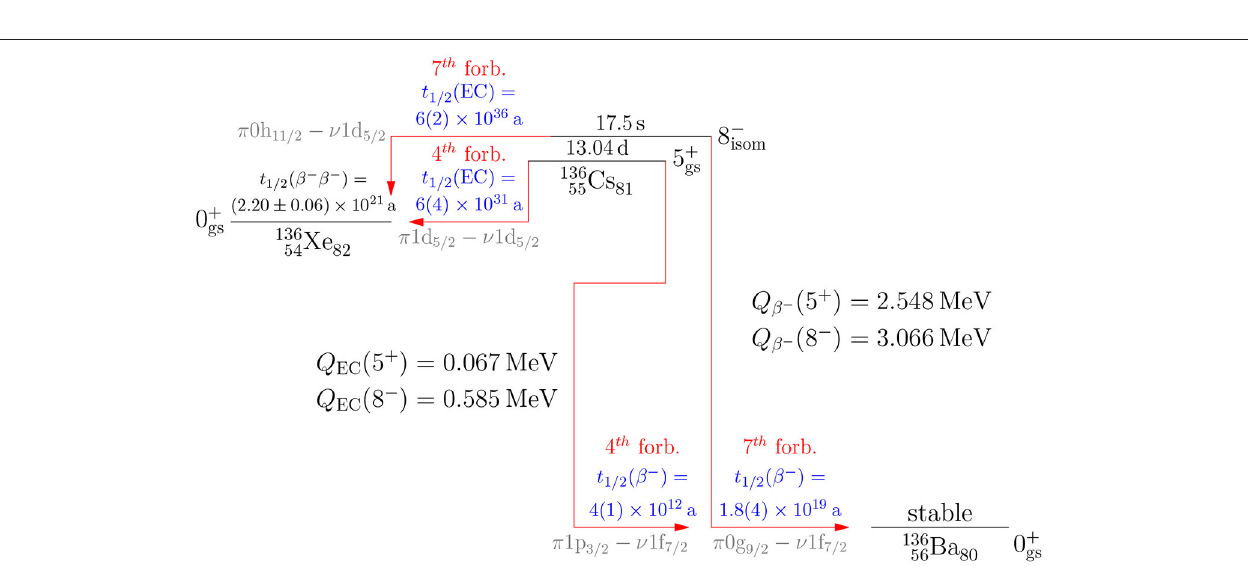
1.0 was assumed and the color coding represents the value of g A . =